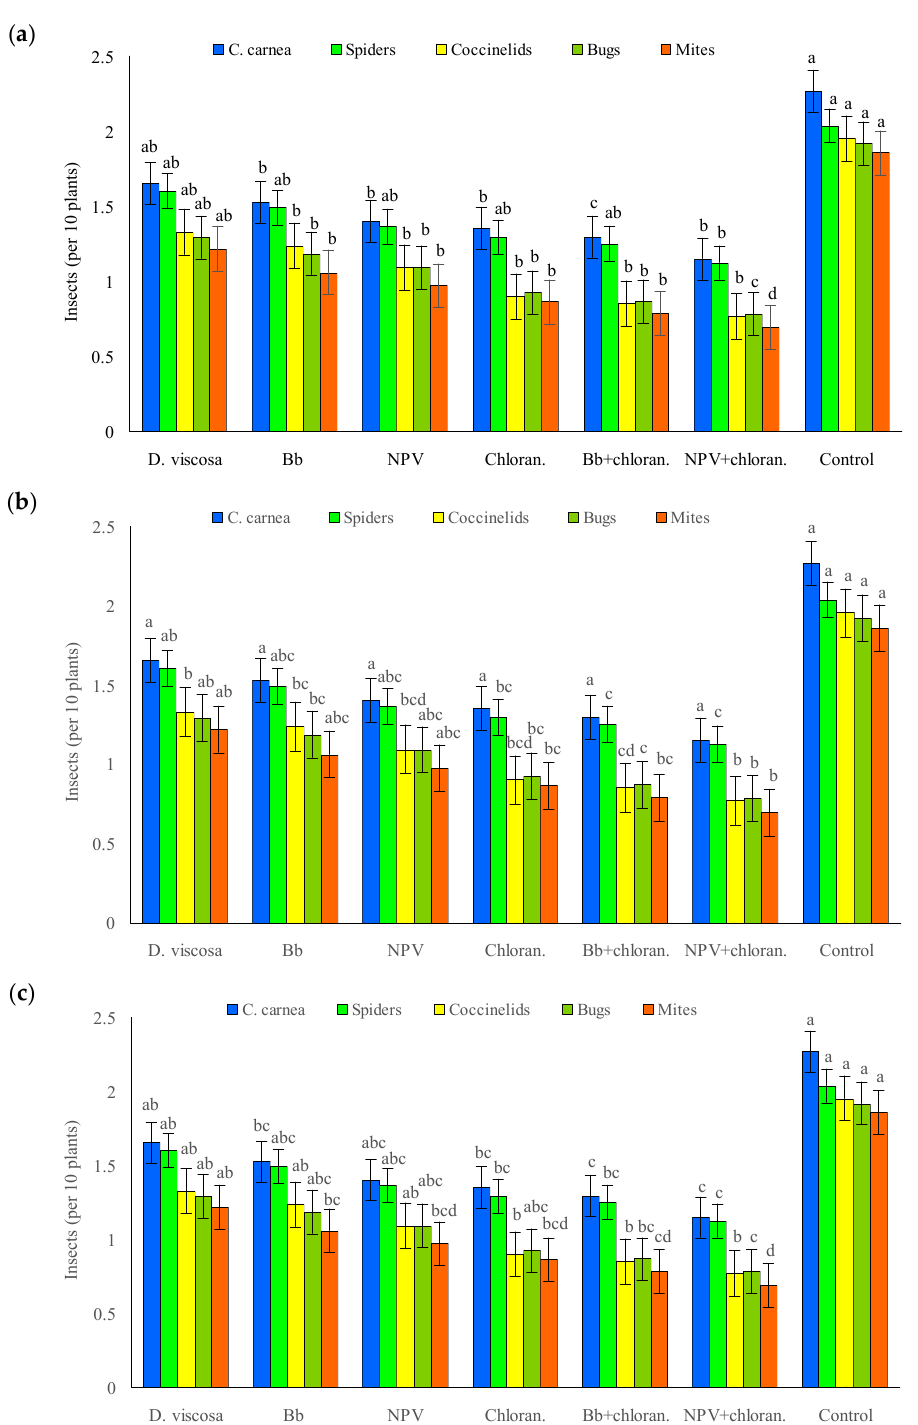
Figure 3. Population density (mean number per ten plants ± SE) of natural enemies following field application of different biorational and chemical control options based on B. bassiana ; HaNPV; D. viscosa and chlorantraniliprole (chloran.) at ( a ) 3 DAT, ( b ) 5 DAT and ( c ) 7 DAT after the second spray at Bahawalpur. Means followed by the same letters are not significantly different from each other within each sample time and for each natural enemy taxon; Tukey-Kramer HSD test at p = 0.05.